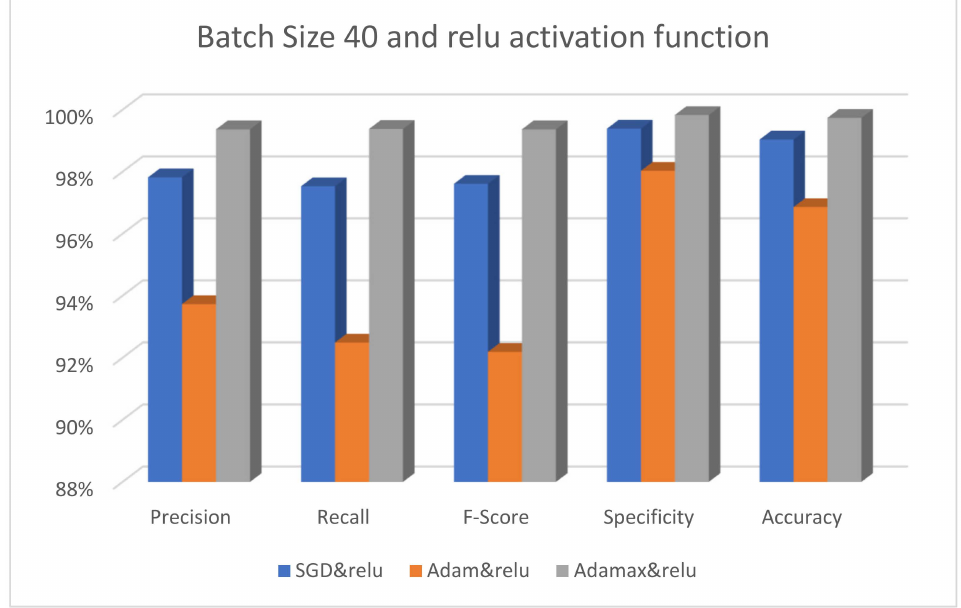
Figure 4. The performance of the ResNet101 model with different optimizers using batch size 40 and the ReLU activation